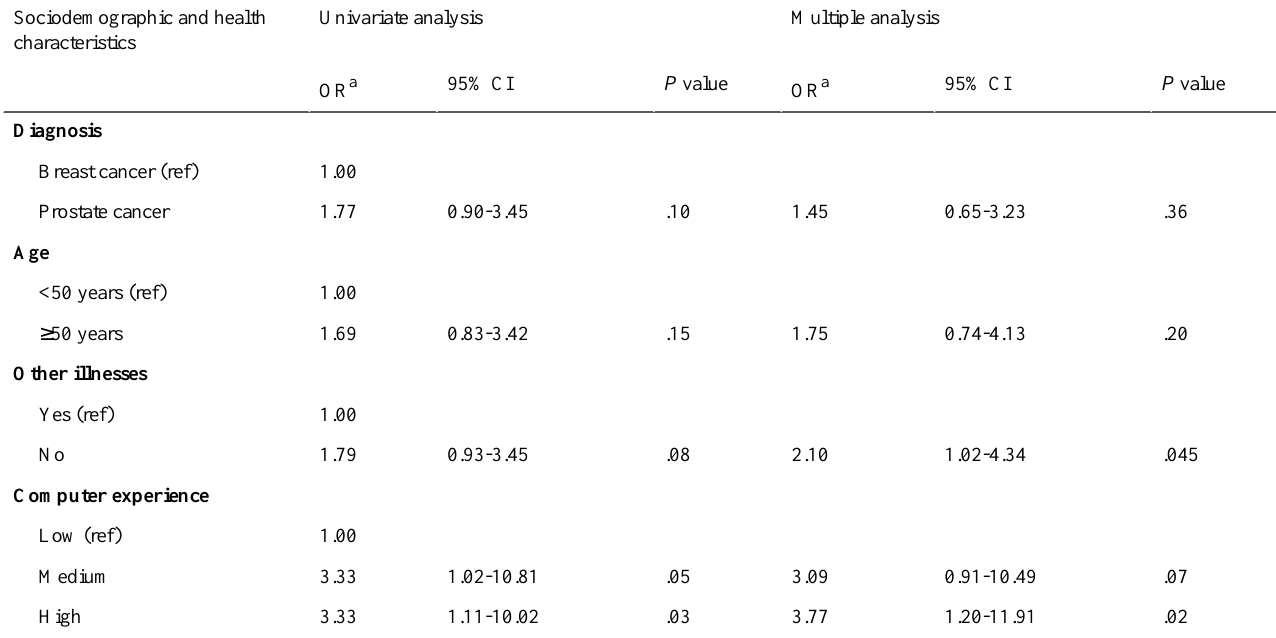
Table 4. Binary logistic regression of patient characteristics and use of WebChoice (2 or more log-ins) (N=162).